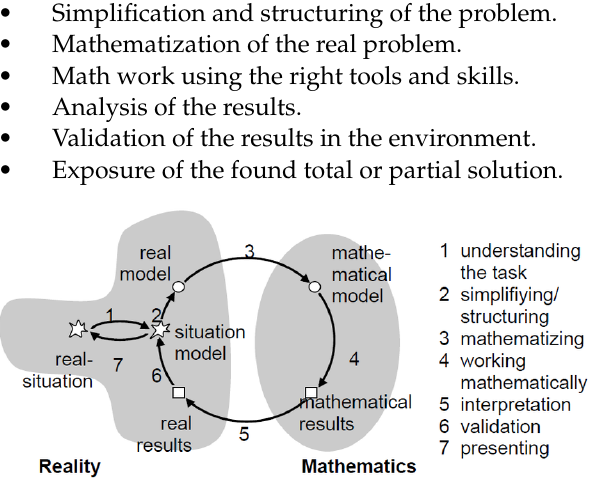
Figure 1. Modeling